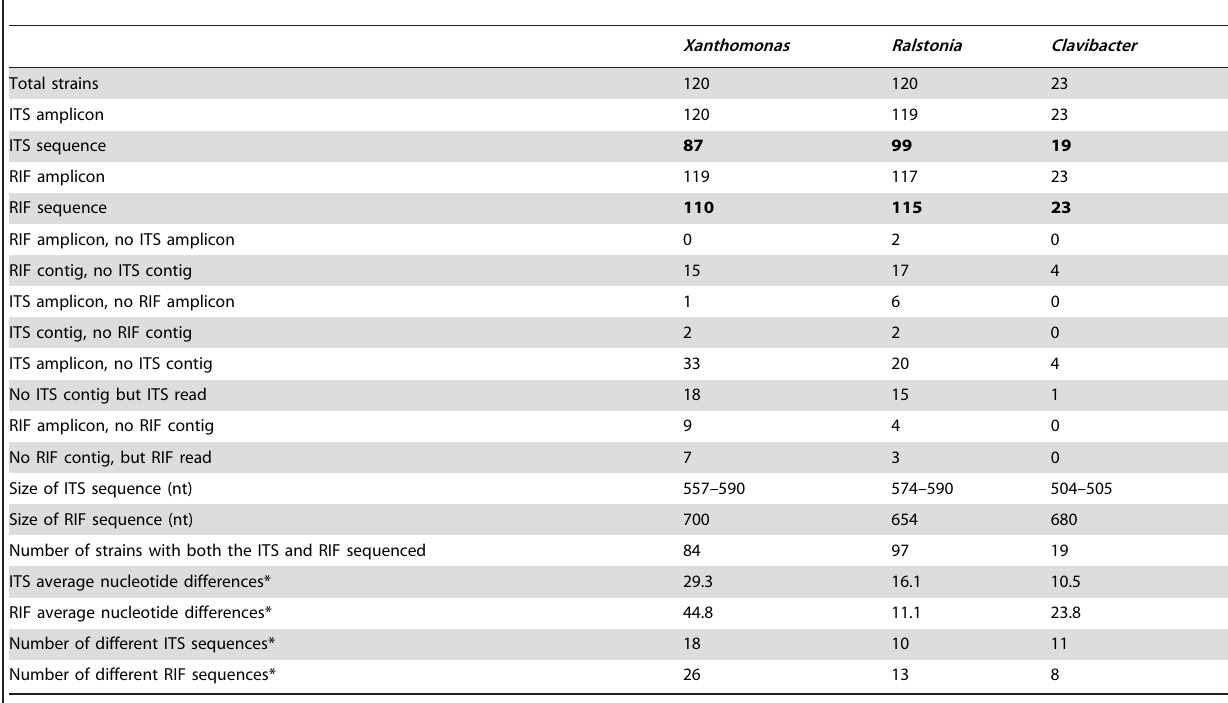
Table 4. RIF sequencing success rate for Xanthomonas , Ralstonia and Clavibacter is higher than